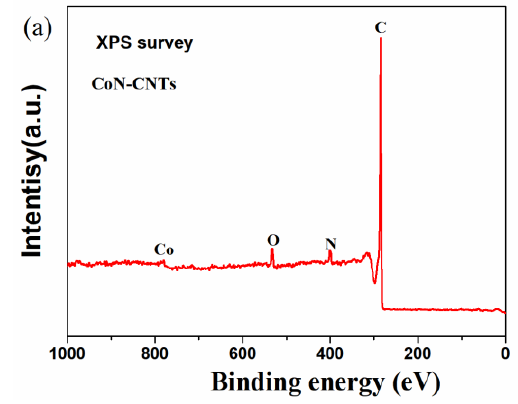
Figure 3. SEM images of Co−N−CNTs synthesized at different temperatures: ( a ) 700 °C, ( b ) 800 °C and ( c ) 900 °C; ( d , e ) EDS mapping images, ( f ) Co, ( g ) C, ( h ) N and ( i ) O of Co−N−CNTs at 800 °C.